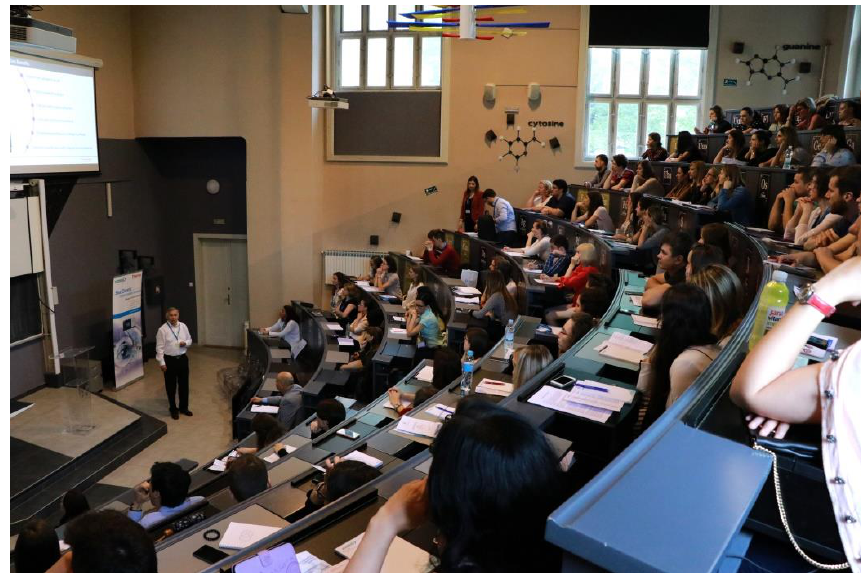
Figure 3. 18th International Chromatography School, Zagreb, Croatia, 2018: Professor Joachim Weiss presented new achievements in chromatography to a large audience.